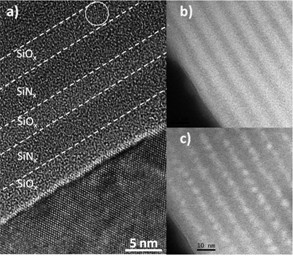
HRTEM (a) and EFTEM (b, c) images. SiOx/SiNy ML annealed at TA = 1,000°C, tA = 1 min by filtering the energy at SiO2 plasmon (b) and Si plasmon (c) energies, respectively.